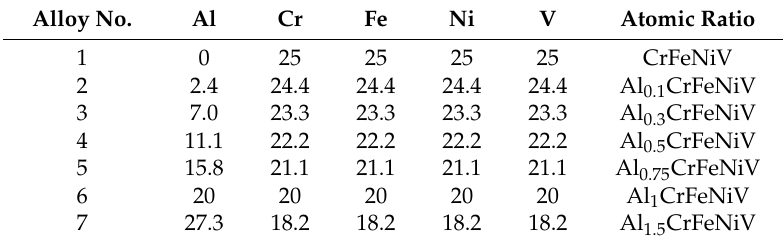
Table 1. The composition of the alloys used in the experiment (at